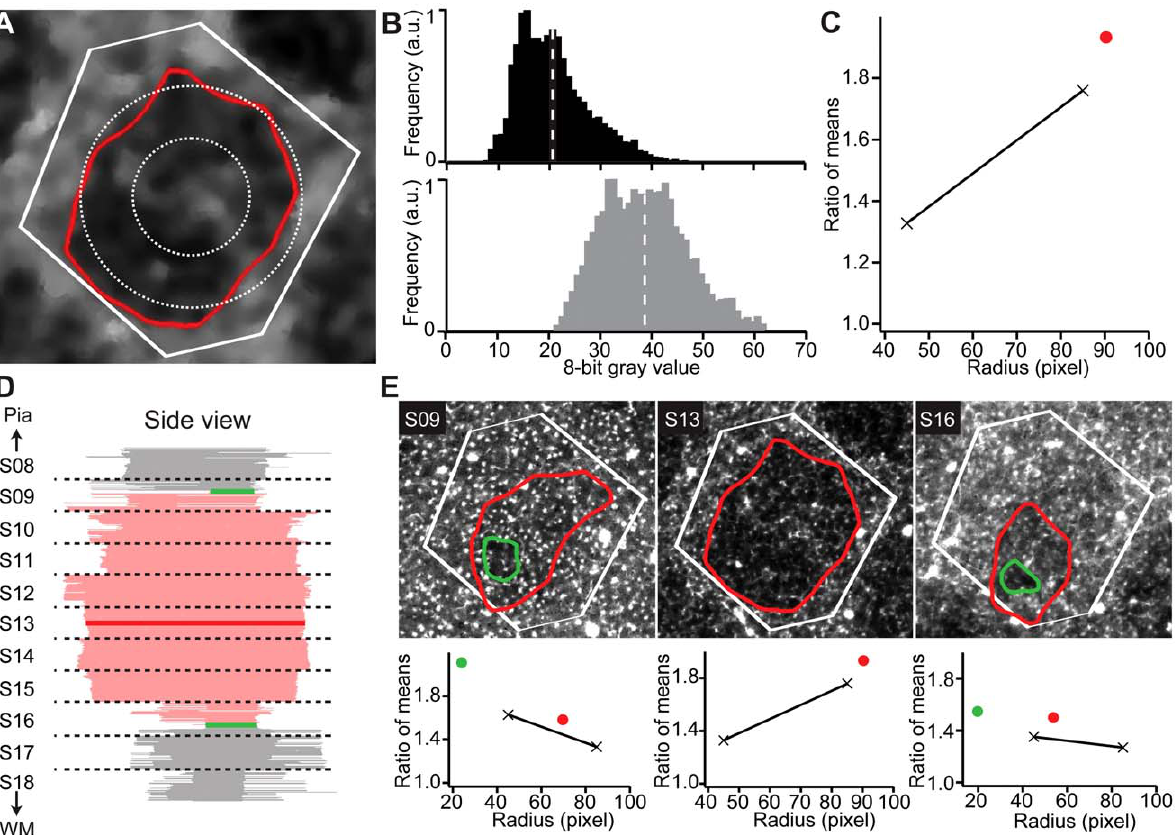
Figure 3. Reconstruction of 3D barrel dimensions. (A) Barrel contour in a single optical section overlaid on the filtered image (gray values linearly enhanced for visualization). White lines indicate border of the VR of this barrel. Dashed circles with diameters of 90 and 170 pixels (approx. 165 and 315 m m) indicate the regions used to estimate the barrel extent. (B) Histogram of background pixels inside the barrel contour in A (black) and histogram of background pixels in septum (gray), i.e. outside of the barrel contour and inside of the VR. Dashed white lines mark mean gray value. (C) Ratio of means inside/outside of the contour as a function of the contour radius. Black: circular regions in A; red: segmented contour. (D) Side view of all segmented contours. Subsequent tangential sections are aligned using blood vessels. (E) Top row: Individual optical sections from different tangential sections (marked bold in D). Red – regular segmented contours. Green – optimized minimal contours. Bottom row: Radial dependence of the ratio of means for all contours in the corresponding optical sections. The slope of the black line gives an estimate of the relative size of the true barrel extent compared to the segmented contour. At the top and bottom of the barrel it may be necessary to segment an optimized minimal contour (see Supplemental Materials).